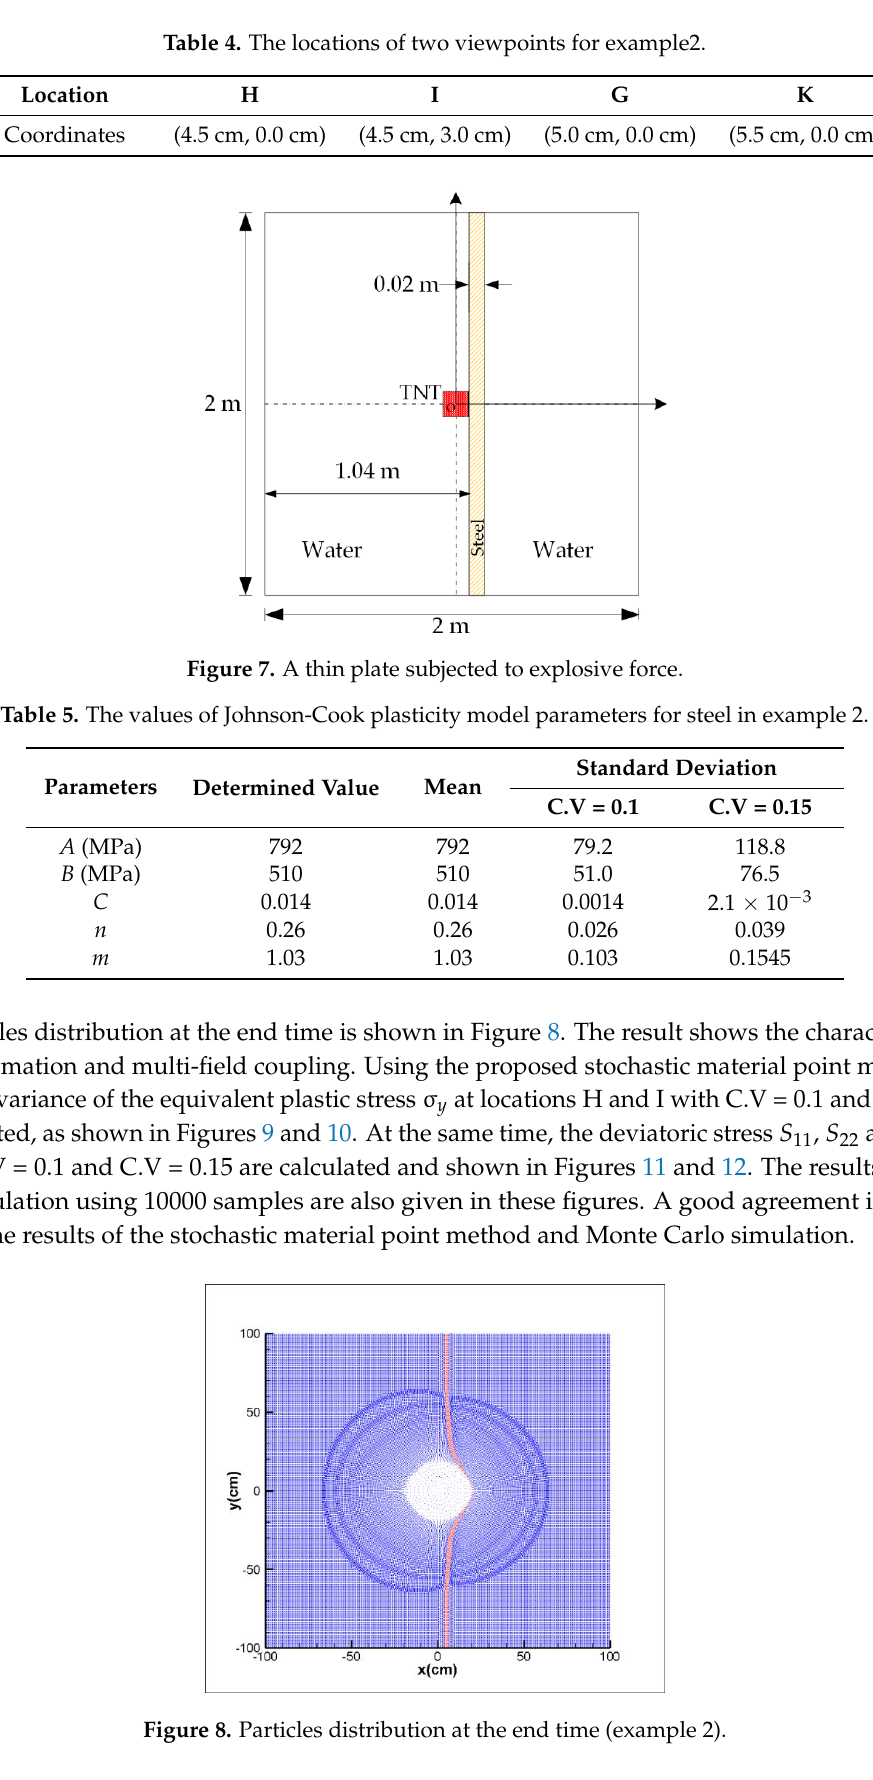
( d ) Figure 9. Equivalent plastic stress σ y response of location H by various methods with C.V=0.1 and C.V = 0.15: ( a ) Mean of σ y with C.V = 0.1; ( b ) Variance of σ y with C.V = 0.1; ( c ) Mean of σ y with C.V = 0.15; ( d ) Variance of σ y with C.V = 0.15.